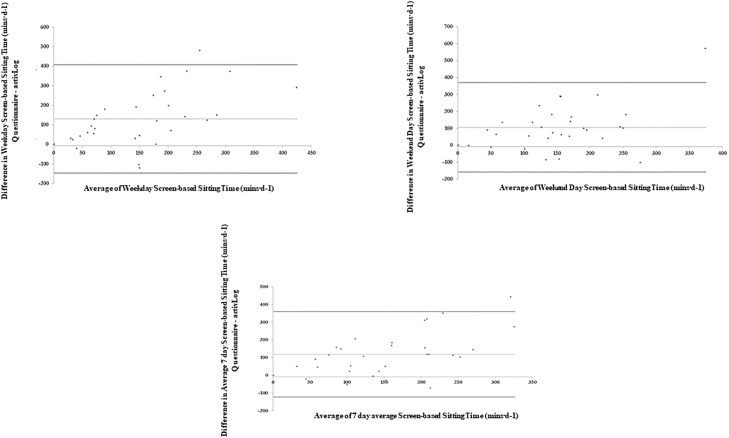
Bland-Altman plots of absolute agreement of screen-based sitting time (weekdays, weekend days and average of last 7 days) derived from the questionnaire with the equivalent variable derived from the criterion measure (combination of AP3M determined sedentary time and the domain specific log).